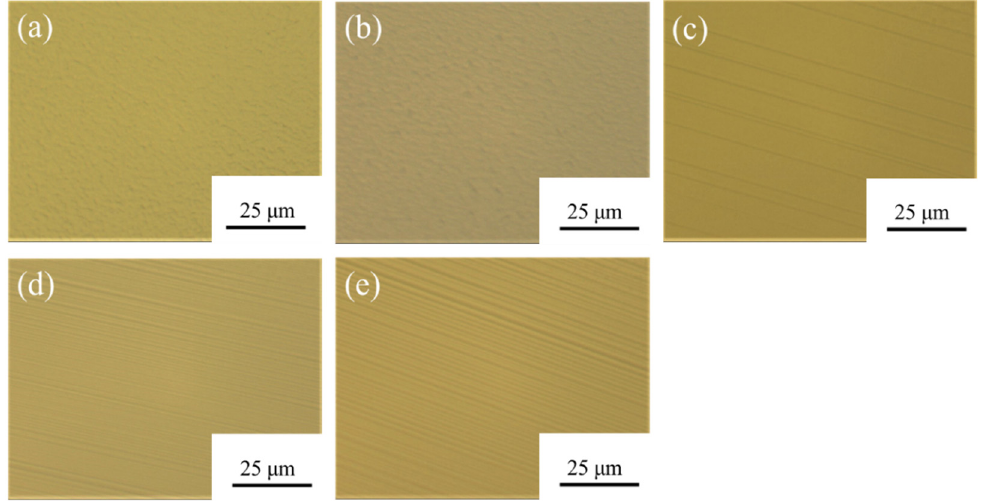
Figure 8. Optical microscope images of 4H-SiC epitaxial wafers with growth temperatures of ( a ) 1550 °C, ( b ) 1580 °C, ( c ) 1600 °C, ( d ) 1620 °C, and ( e ) 1650 °C.